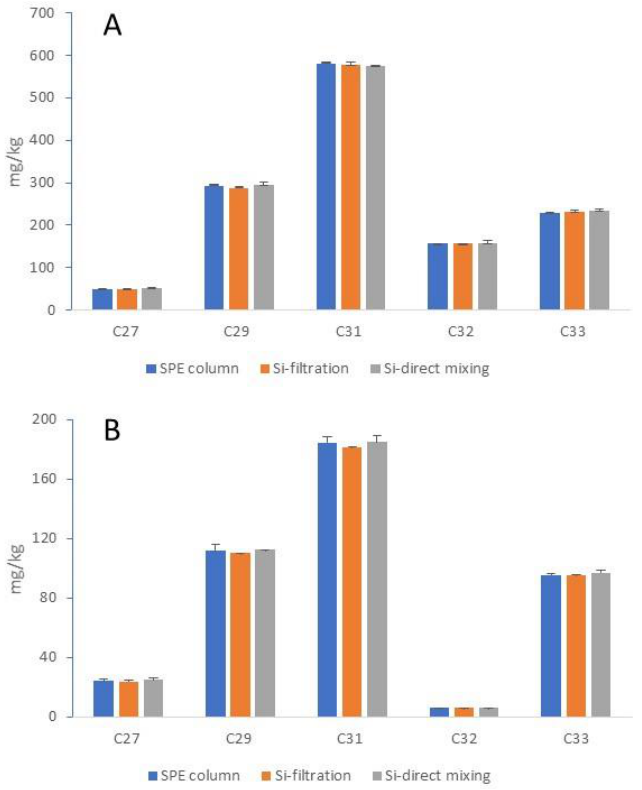
Figure 4. Comparison of three sample purification methods. Each column is the mean of two replicates and error bars are standard deviations (SD). ( A ): faeces; ( B ): herbage. Note: no significant difference was found for any n -alkane across the three methods (statistical symbols omitted).